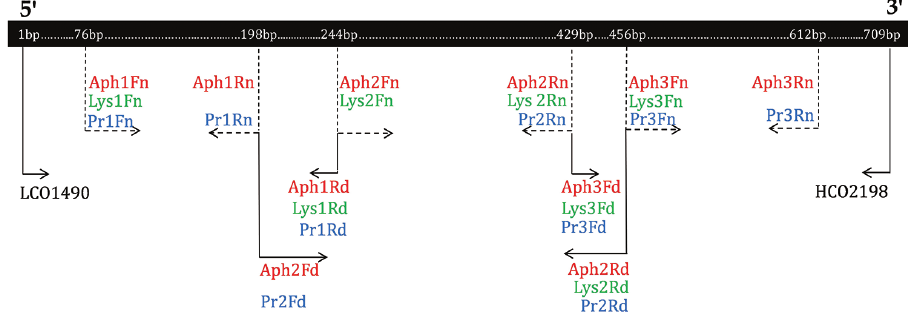
Figure 1. Position of internal degenerative primers within the barcoding region of COI. Aphidius - specific primers: Aph1Fn, Aph1Rn, Aph1Rd, Aph2Fd, Aph2Fn, Aph2Rn, Aph2Rd, Aph3Fd, Aph3Fn and Aph3Rn; Lysiphlebus - specific primers: Lys1Fn, Lys1Rd, Lys2Fn, Lys2Rn, Lys2Rd, Lys3Fd and Lys3Fn; Praon - specific primers: Pr1Fn, Pr1Rn, Pr1Rd, Pr2Fd, Pr2Rn, Pr2Rd, Pr3Fd, Pr3Fn and Pr3Rn. Arrows refer to the